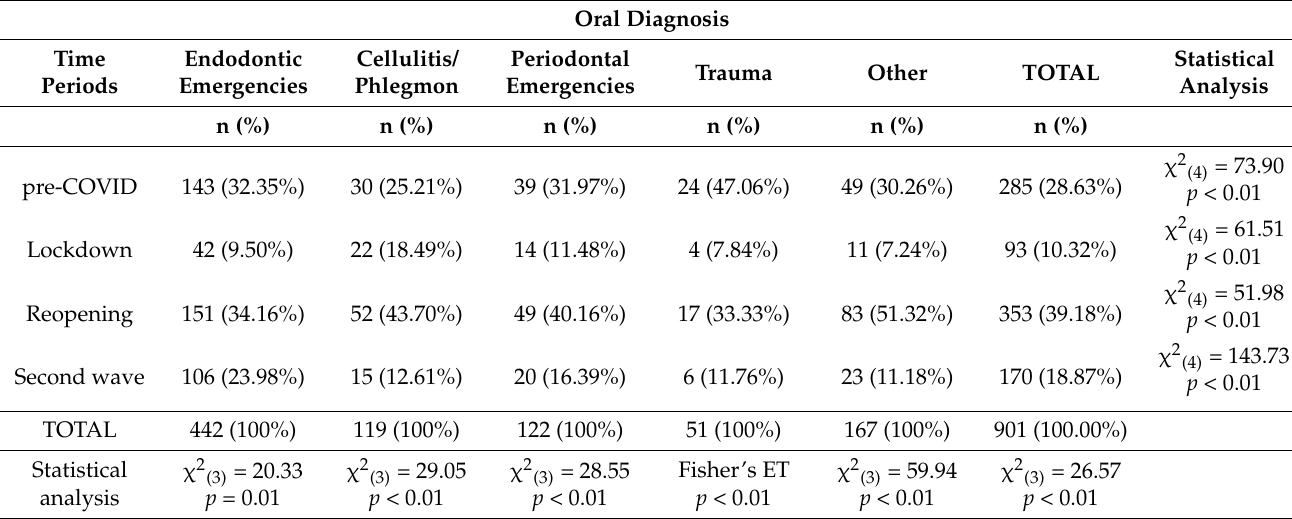
Table 2. Oral diagnoses performed during the four time periods and column and row statistical analysis. Percentages are calculated in columns, except for the total column in